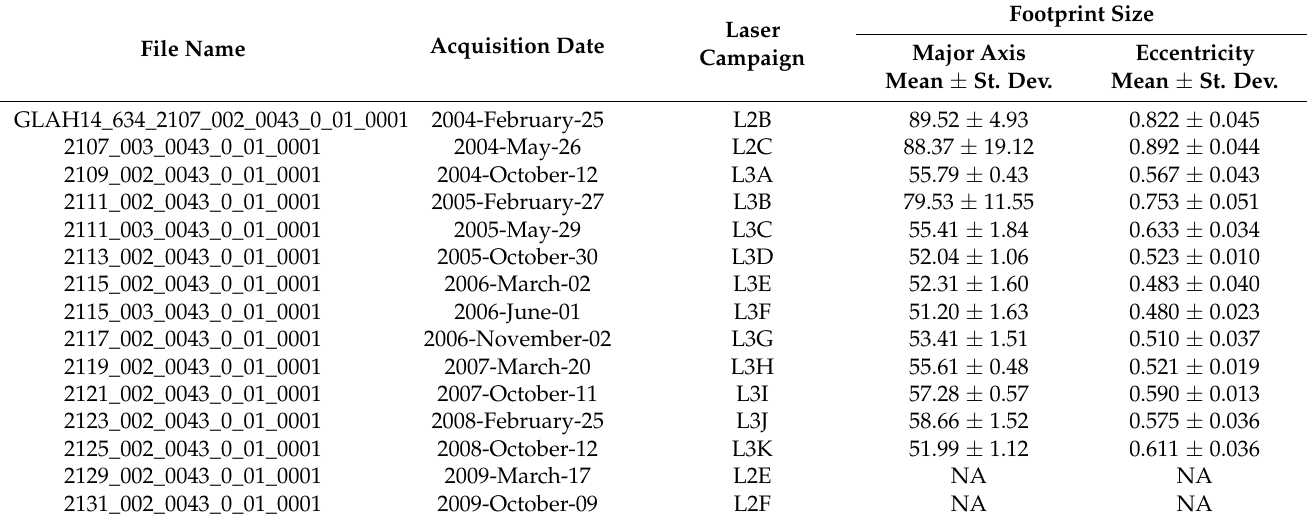
Table 3. ICESat profiles used in this